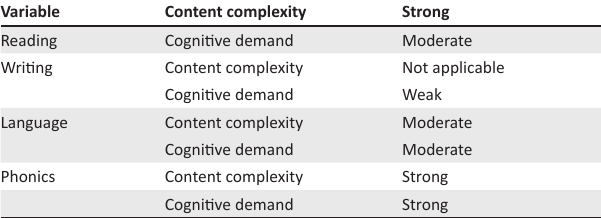
TABLE 3: Progression in the EHL workbooks across language content areas.